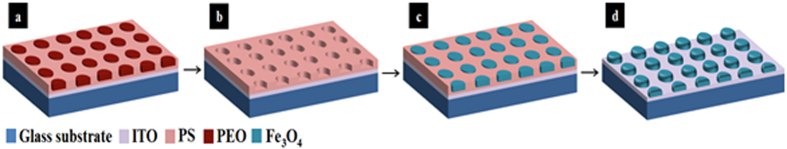
Schematic of Fe3O4 nanodots fabrication.(a) Deposition of PS-b-PEO on the ITO glass substrate. (b) Wet etch removal of PEO and formation of a porous template. (c) Deposition of iron nitrate solution on the PS template. (d) Formation of Fe3O4 dots after PS removal using UV/Ozone.